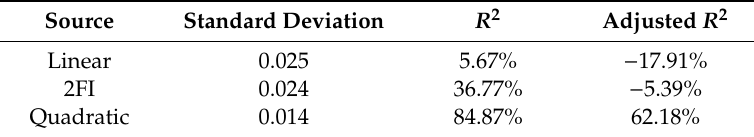
Table 3. Performance statistics summary of the various